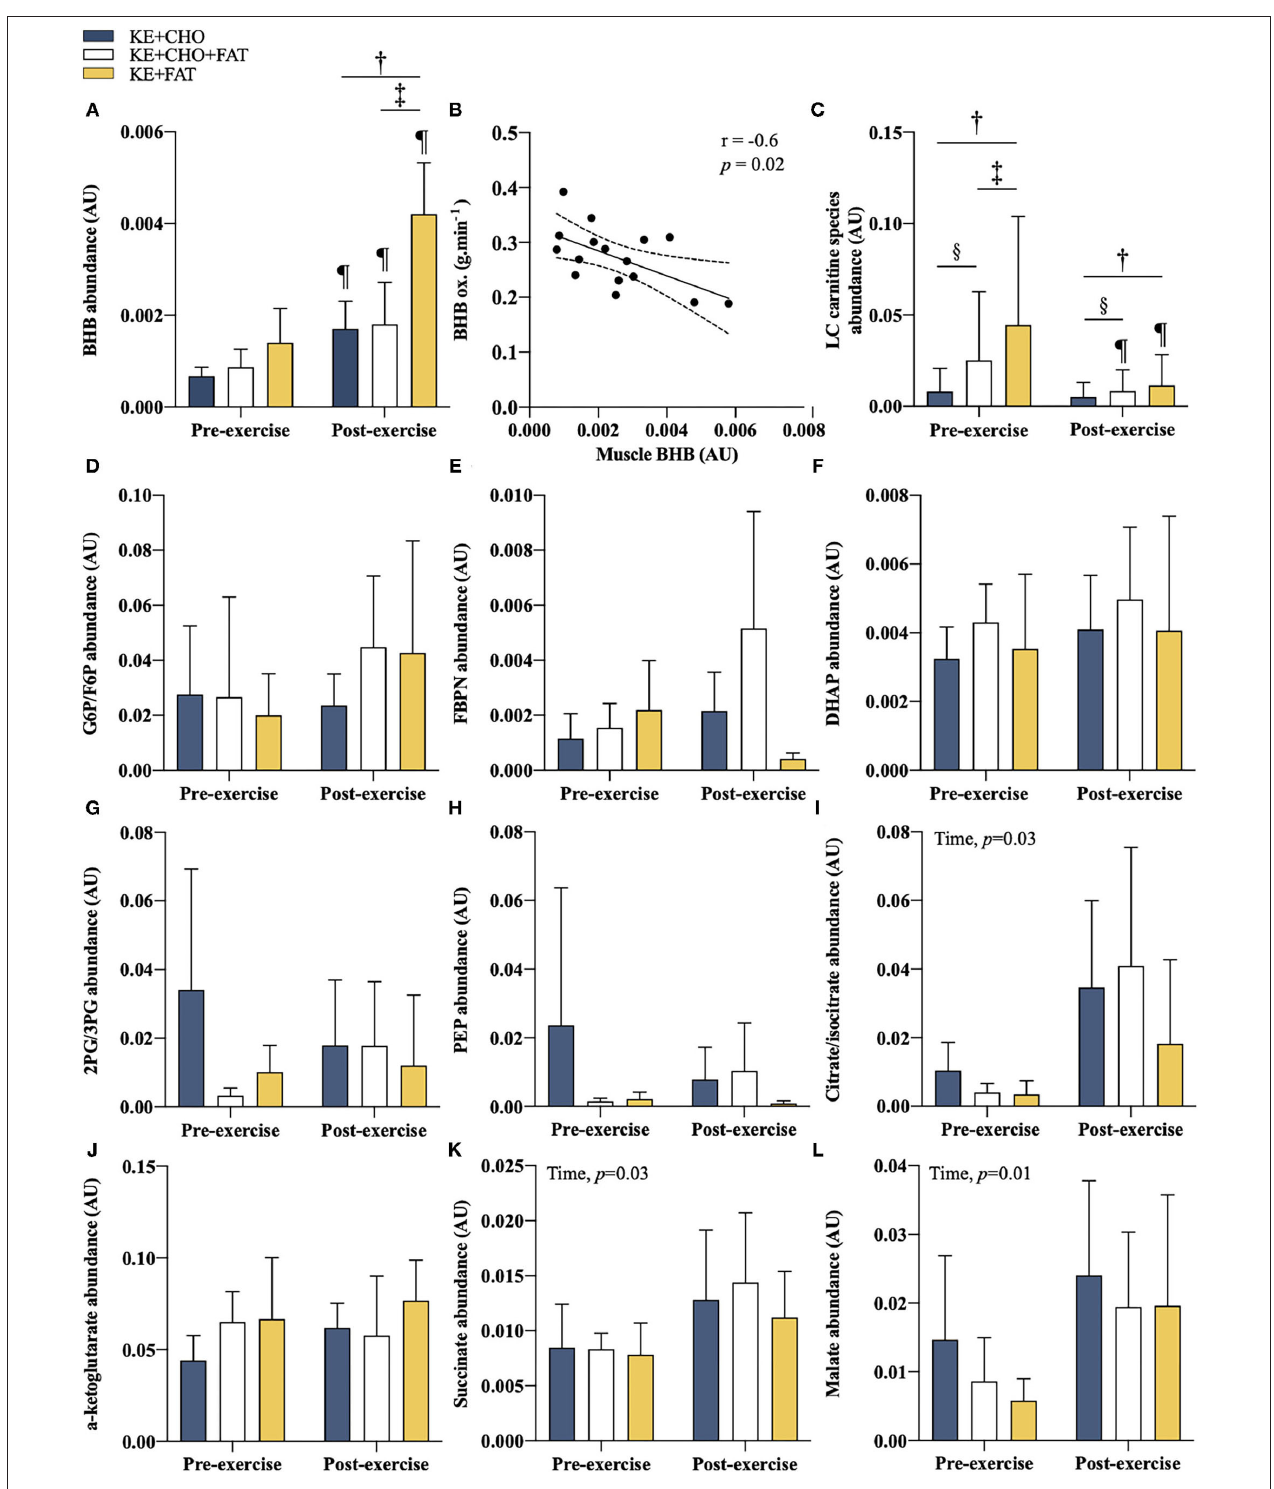
FIGURE 6 | Intramuscular metabolites. (A) β HB pre- and post-exercise. (B) Association between post-exercise intramuscular β HB and β HB oxidation rate at t = 60min. Limits represent 95% CI. (C) Long-chain acylcarnitines (C12 to C18) abundance pre- and post-exercise. (D) glucose 6 phosphate (G6P)/fructose 6-phosphate (F6P) pre- and post-exercise. (E) fructose 1,6-bisphosphate (FBPN) pre- and post-exercise. (F) dihydroxyacetone phosphate (DHAP) pre- and post-exercise. (G) 2-Phosphoglyceric acid (2PG)/3-Phosphoglyceric acid (3PG) pre- and post-exercise. (H) phosphoenolpyruvic acid (PEP) pre- and post-exercise. (I) Citrate/isocitrate pre- and post-exercise. (J) α -ketoglutarate pre- and post-exercise. (K) Succinate pre- and post-exercise. (L) Malate pre- and post-exercise. Significant post-hoc comparisons: † = KE + CHO vs. KE + FAT; ‡ = KE + CHO + FAT vs. KE + FAT; § = KE + CHO vs. KE + CHO + FAT; ¶ = Pre- vs. post-exercise. Values = mean ± SD.